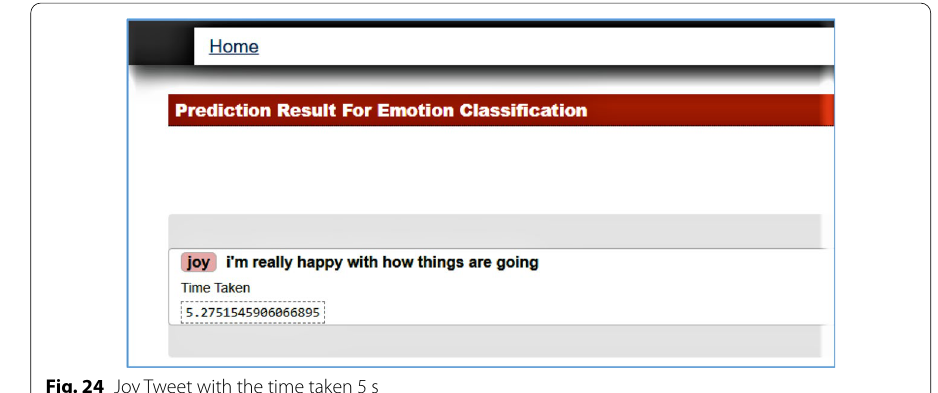
Fig. 24 Joy Tweet with the time taken 5 s